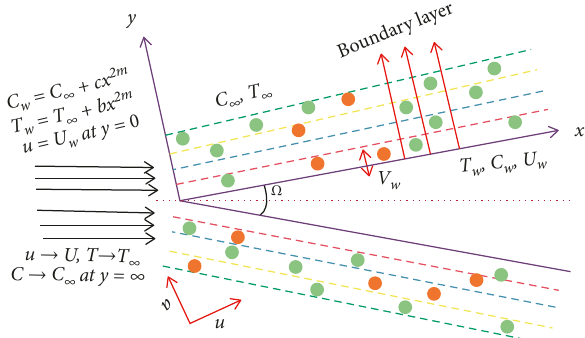
Figure 1: Physical model of the